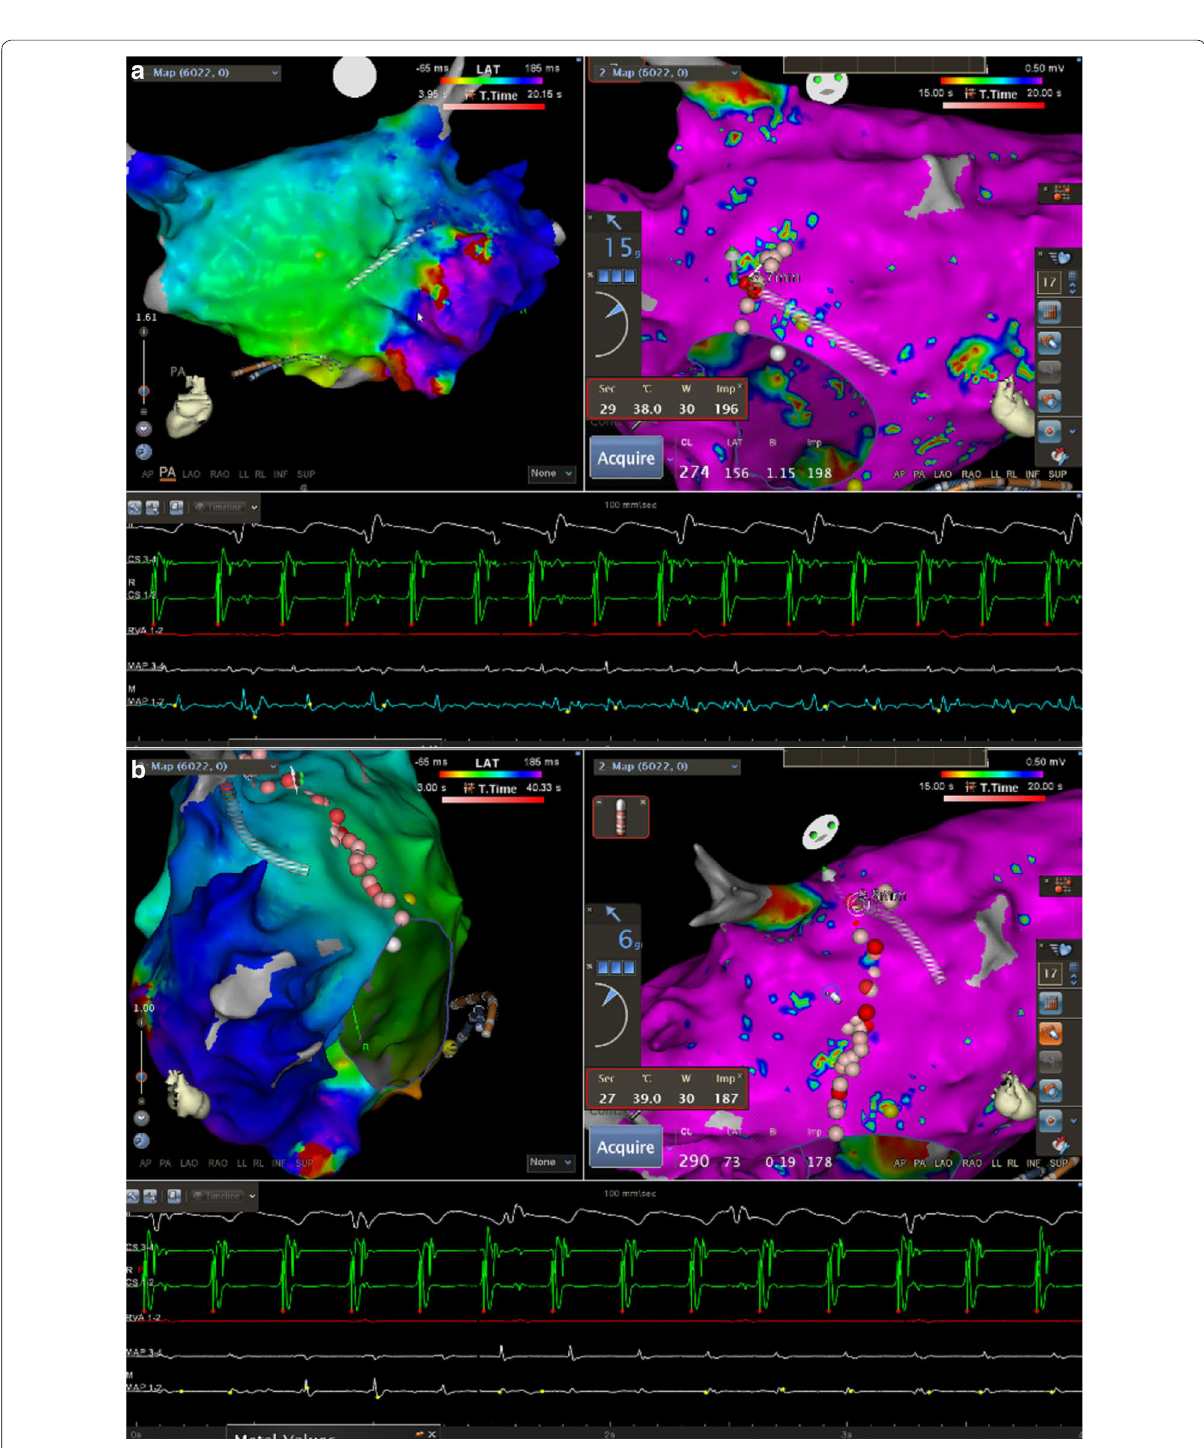
Fig. 3 The first ablation line. a The first ablation line was performed from 12’ clock of tricuspid annulus to right superior pulmonary vein (RSPV). During ablation of this line, CL of atrial flutter prolonged from 260 to 275 ms. b CL of atrial flutter increased to 290 ms but tachycardia did not terminate when the first ablation line